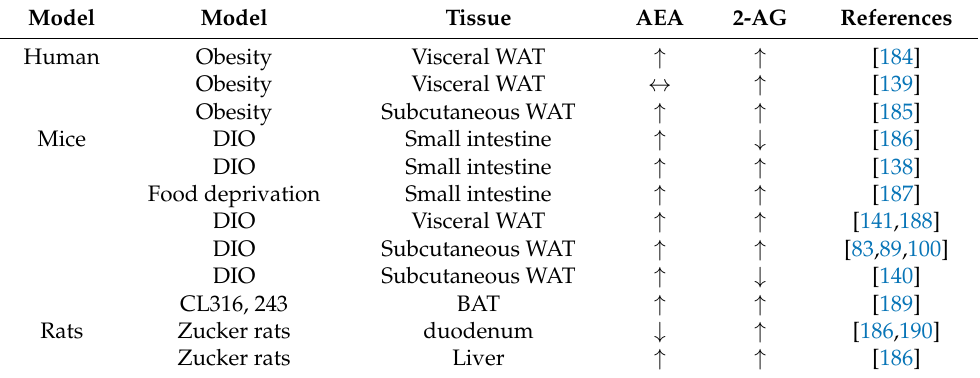
Table 3. Circulating level of endocannabinoids associated with obesity. AEA and 2-AG detected in various tissues are modulated according to the metabolic condition. DIO, diet-induced